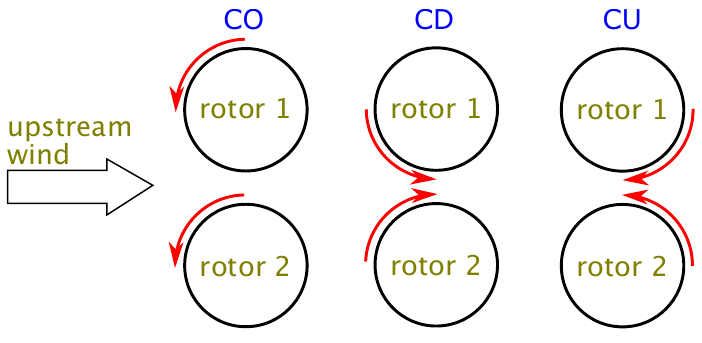
Figure 1. Layouts of